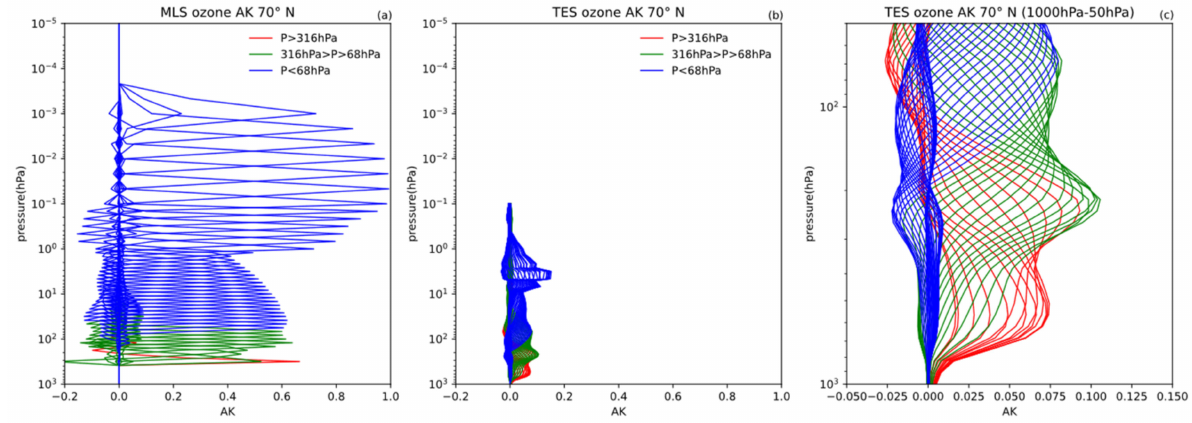
Figure 3. Vertical averaging kernels of ( a ) MLS ozone and ( b ) TES ozone at 70 ◦ N. ( c ) The partial enlargement of ( b ) between 1000 hPa and 50